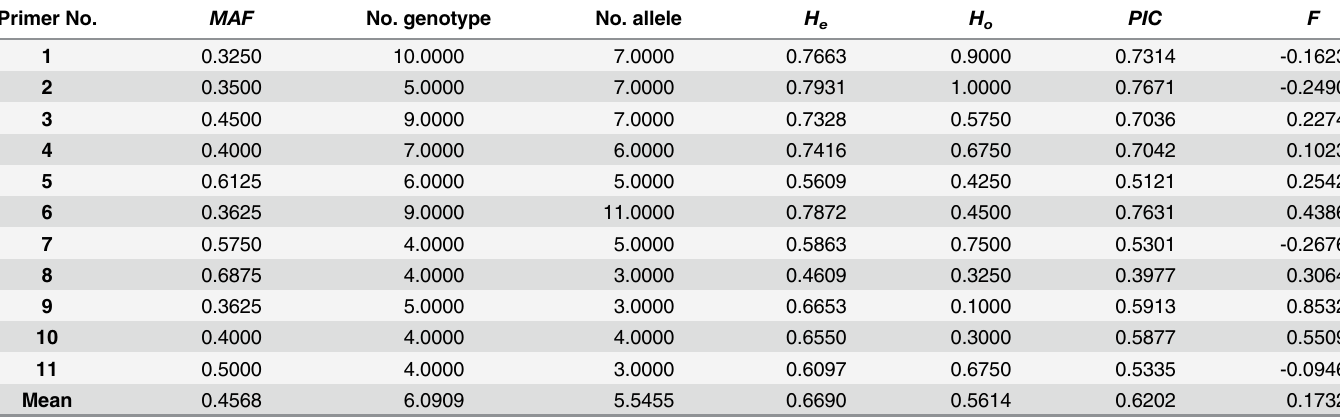
Table 2. Genetic diversity in the selected second-generation Chinese pine ZN-NP population. Primer